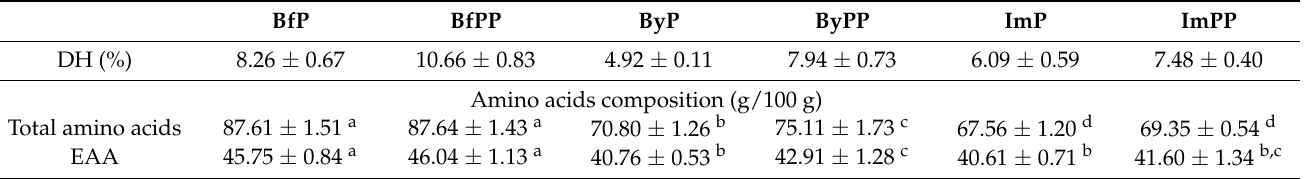
Table 1. The degree of hydrolysis (DH) and amino acid compositions of beef and PBMA hydrolysates.